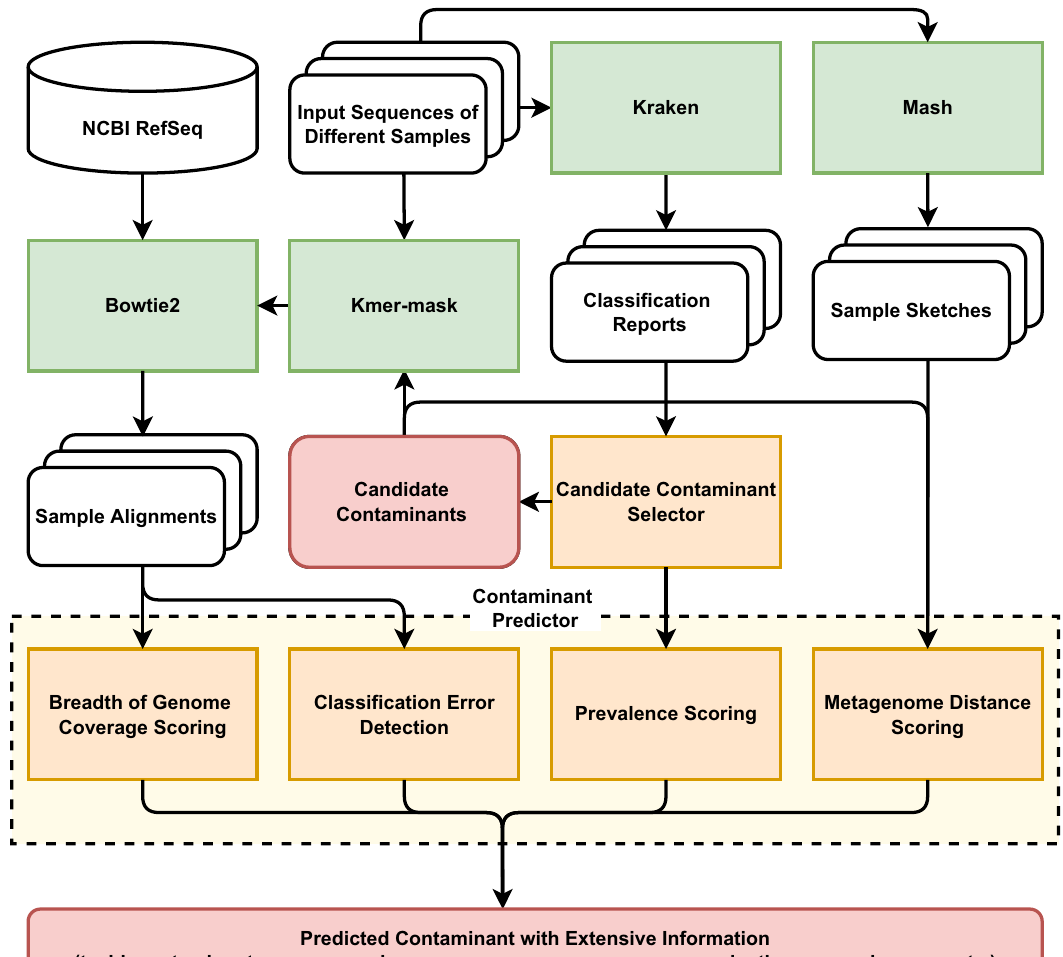
Fig.1|Squeegeepipelinework fl ow. Squeegeestartswithtaxonomicclassi fi cation using Kraken to determine a set of candidate contaminant species. Reads from the inputdataarealignedtotherepresentativegenomesofthecandidatecontaminant